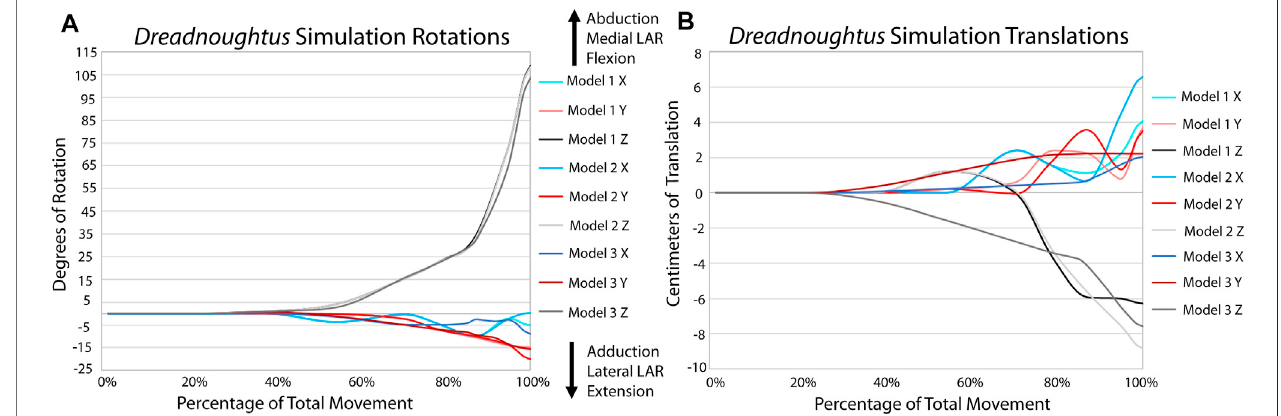
FIGURE 7 | Comparison of kinematic data of the three simulations of the Dreadnoughtus elbow. (A) Comparison of rotational data. (B) Comparison of translational data.